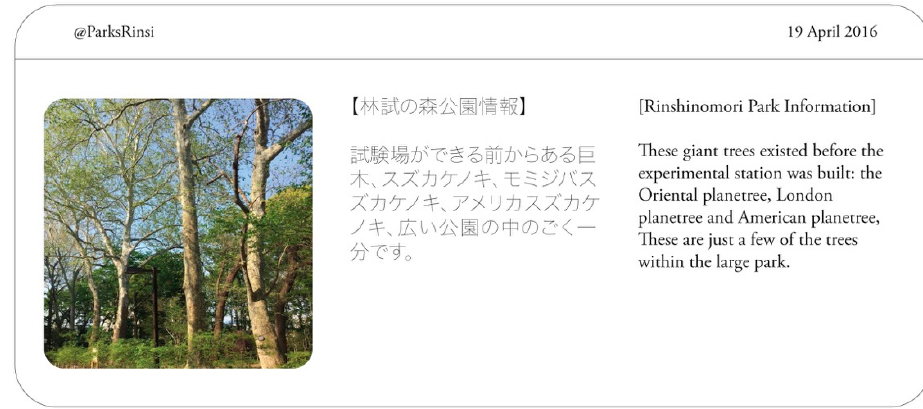
Figure 3. Narrative voice. This tweet talks about the history of the park through the trees. Original Japanese text and English translation